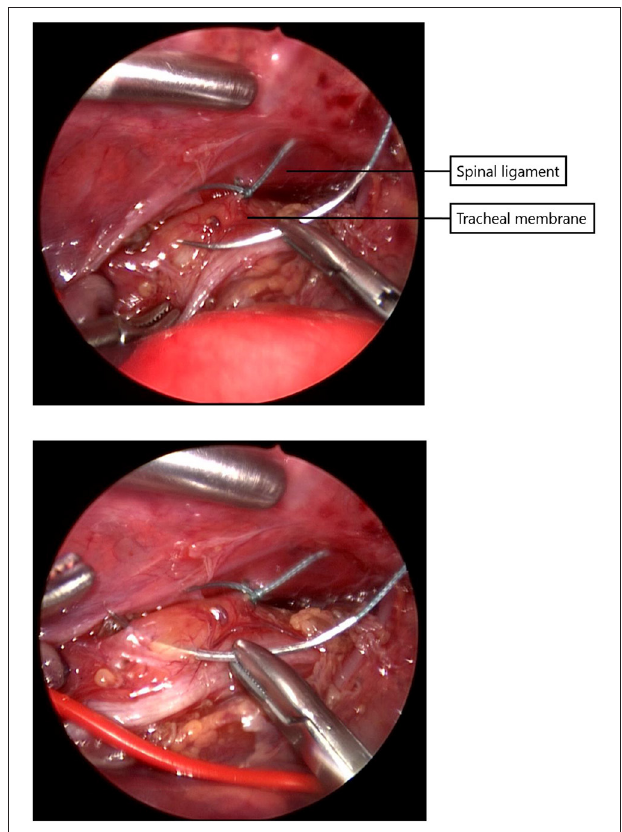
FIGURE 1 | The posterior tracheal membrane is fixed to the the anterior spinal ligament with one to three non-absorbable